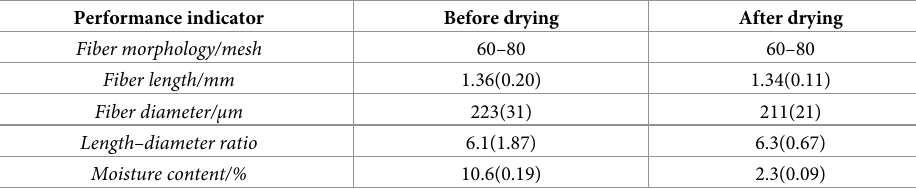
Table 1. Performance indicators of poplar fibers before and after drying treatment.